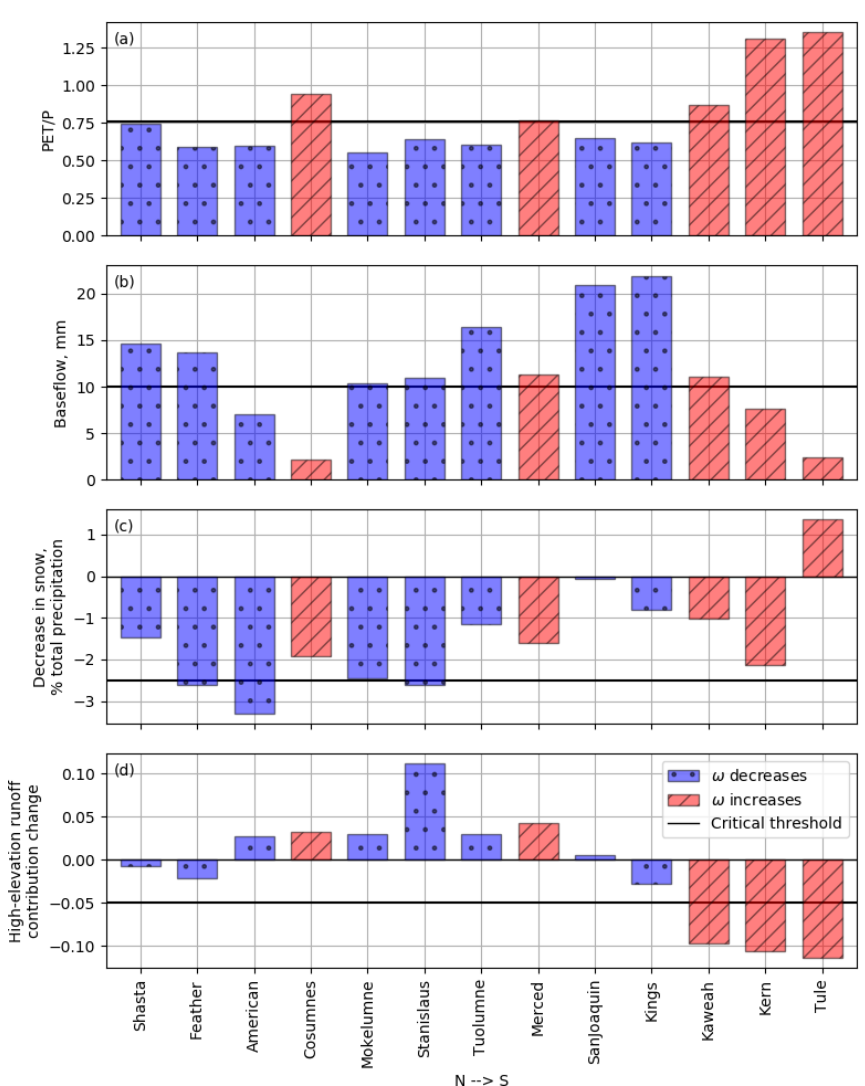
Figure 6. Basin responses driving partitioning shifts. Increases in ω reflect a shift in favor of ET; decreases reflect a shift in favor of